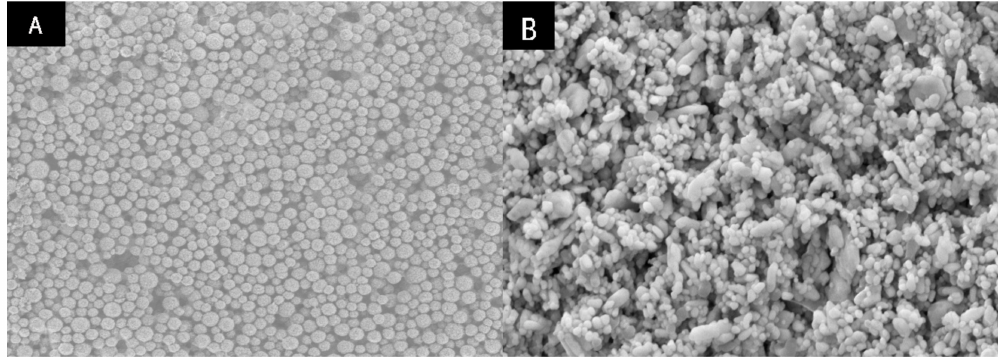
Figure 7. SEM micrographs of the BaSO 4 multifunctional layer with different BaSO 4 particles (( A ) BaSO 4 microspheres, ( B ) amorphous BaSO 4